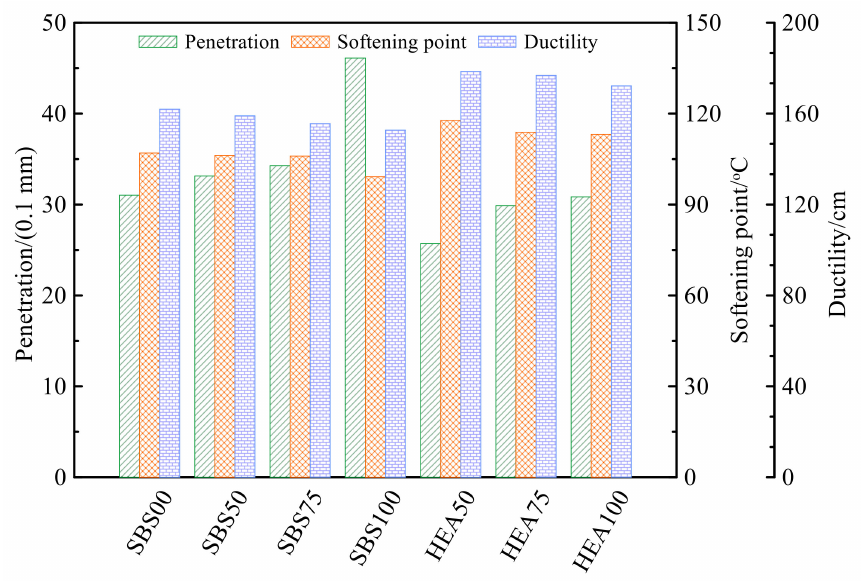
Figure 2. Basic properties of asphalt